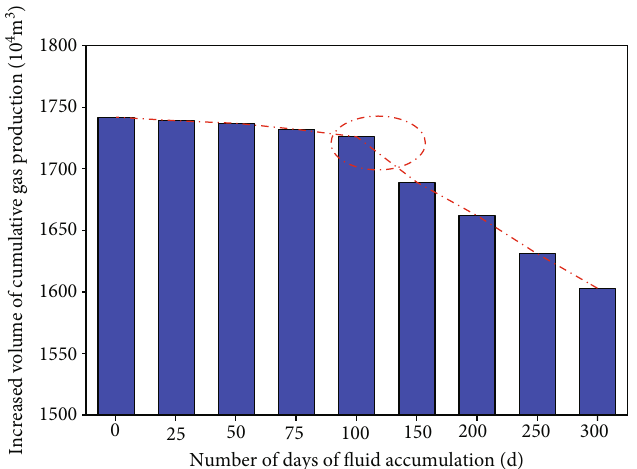
Figure 5: Production increasing of di ff erent fi shing